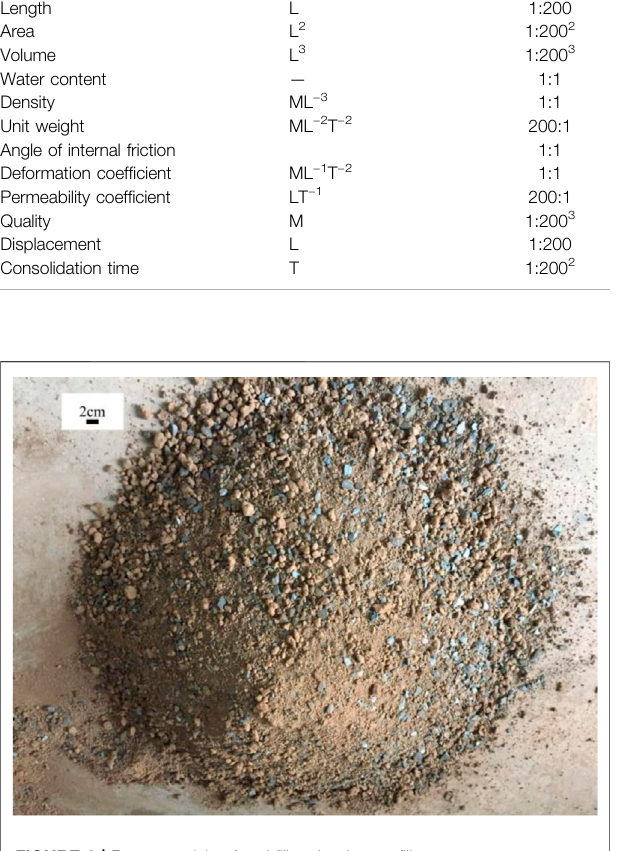
FIGURE 3 | Raw materials of rock fi ll embankment fi llers.